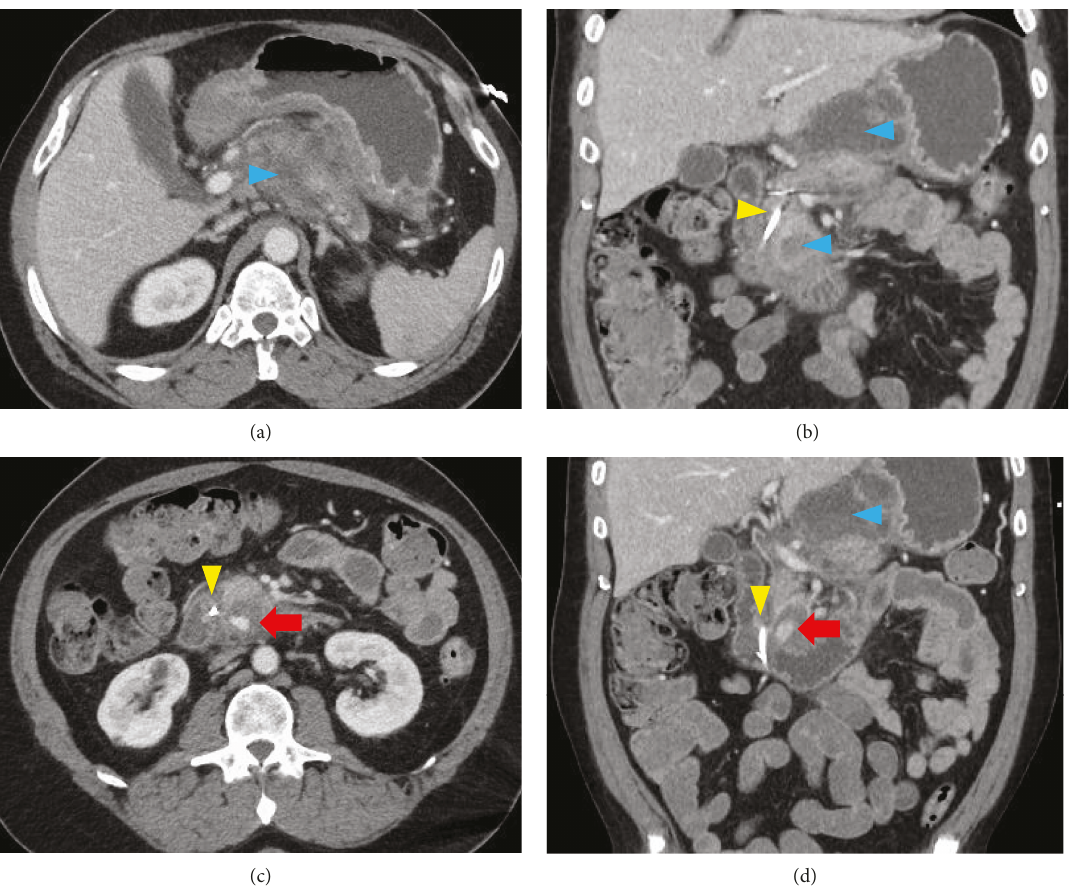
Figure 1: CT showing pancreas with necrotic fl uid collections on axial (a) and coronal (b) sections. Contrast extravasation into the IPDA pseudoaneurysm (red arrows) on axial (c) and coronal (d) sections. Yellow arrowheads point to pancreatic duct stent. Blue arrowheads point to pancreatic fl uid